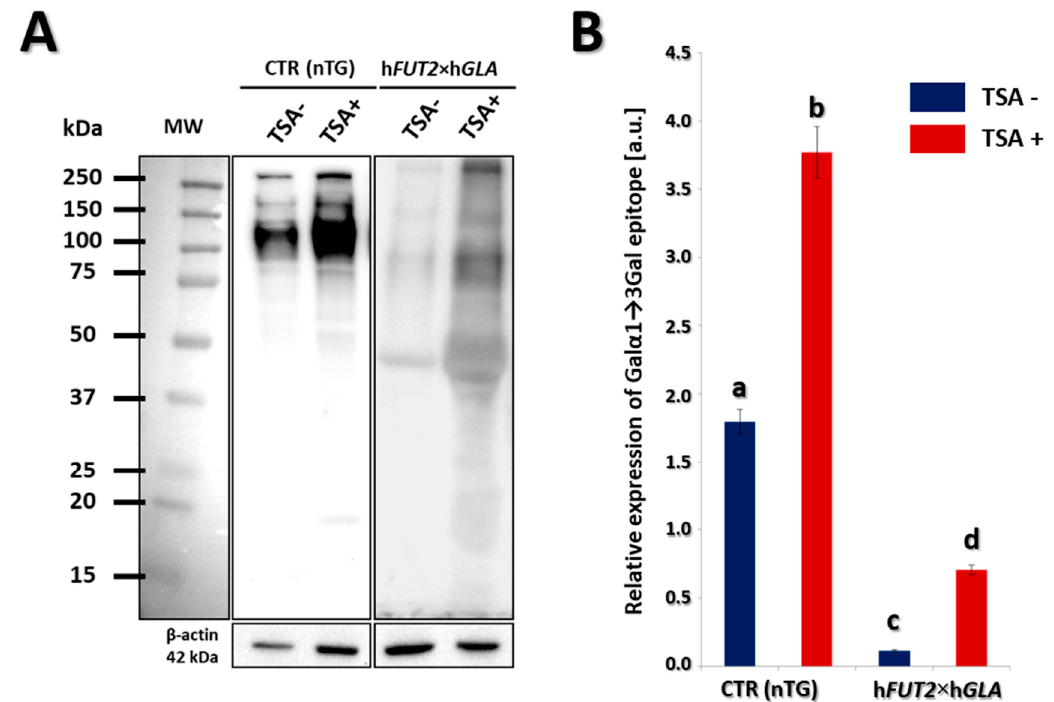
Figure 4. Lectin blotting analysis of Gal α 1 → 3Gal epitope expression at the protein level in the in vitro cultured porcine transgenic and non-transgenic ACFCs treated (TSA + ) and not treated with trichostatin A (TSA − ). ( A ) Representative lectin blots of the expression of Gal α 1 → 3Gal epitope in TSA − and TSA + in vitro-cultured ACFCs derived from non-transgenic (CTR nTG) control and double-transgenic (h FUT2 × h GLA ) pigs. MW indicates the molecular weight of protein standards (Precision Plus Protein Dual Color Standards, Bio-Rad). Each band represents a glycosylated protein containing the Gal α 1 → 3Gal epitope. β -Actin served as a loading control for all analyzed samples. ( B ) The semi-quantitative analysis of Gal α 1 → 3Gal epitope relative expression (in arbitrary units). Relative optical density (ROD) from three separate analyses of at least three animals for each variant is expressed as mean. Graph bar shows mean ± SEM. Statistics: One-way ANOVA and Tukey’s HSD post hoc test. The bars marked with different letters differ significantly. Values denoted as a-b, a-c, a-d, b-c, b-d: p < 0.01; c-d: p < 0.05. The relative expression of Gal α 1 → 3Gal epitope was significantly lower in the ACFCs stemming from h FUT2 × h GLA bi-transgenic pigs as compared to the control (CTR nTG) non-transgenic animals. It is also noteworthy to highlight the fact that the TSA − cell samples derived from h FUT2 × h GLA double-transgenic pigs were characterized by the remarkably lowest expression of Gal α 1 → 3Gal epitopes. However, expression of Gal α 1 → 3Gal epitopes was significantly higher in TSA + cell samples compared to that identified for their TSA − counterparts derived from both transgenic and non-transgenic pigs.